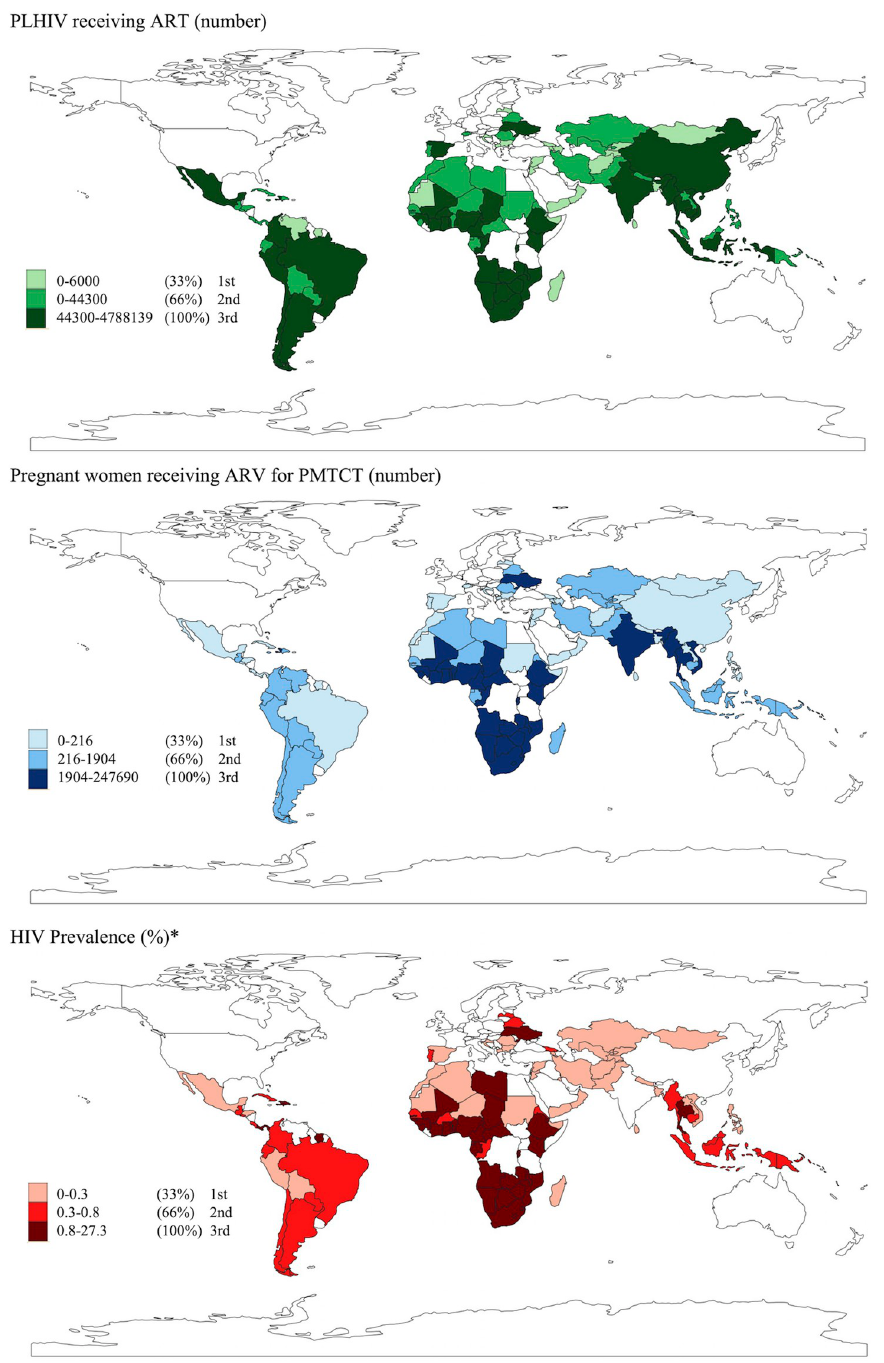
Fig 2. Raw input and output variables terciles by country (N = 78). Notes : Raw variables presented before transforming them into proportions. � White areas for HIV prevalence were missing but some of them were imputed afterwards for analytical purposes. Data used to generate the maps is included in S1 and S2 Data. Maps were created using “QGIS Geographic Information System” from the Open Source Geospatial Foundation Project (http://qgis. osgeo.org). The QGIS Geographic Information System is a free and open source software, for more details on copyright: https://www.qgis.org/en/site/getinvolved/governance/trademark/index.html#:~:text=QGIS%20trademarks %2C%20service%20marks%2C%20logos,all%20uses%20of%20QGIS%20Marks.